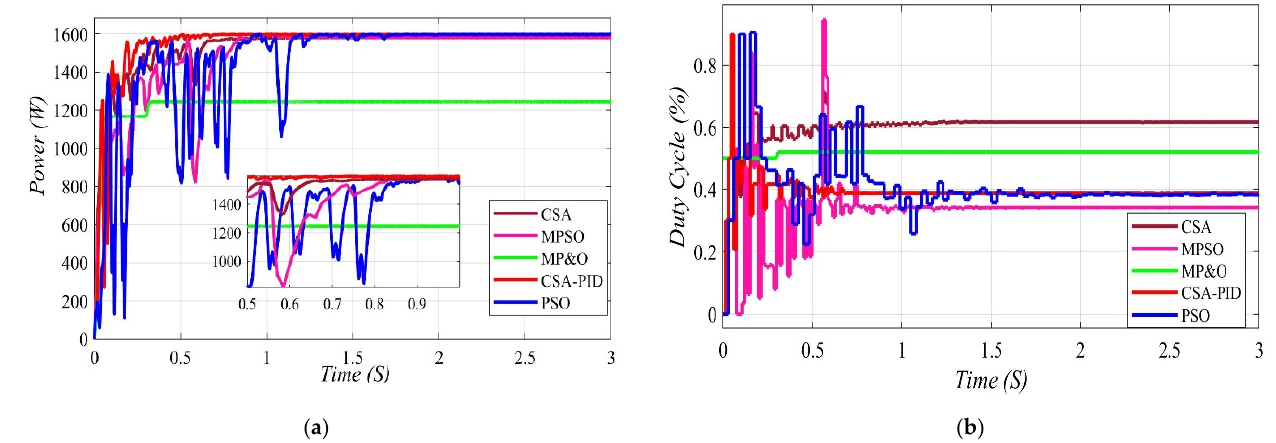
Figure 16. Details of duty cycle and power for proposed CSA-PID, CSA, MPSO, PSO, and MP&O controllers under scenario two. ( a ) The output power of proposed CSA-PID, CSA, MPSO, PSO, and MP&O. ( b ) The output duty cycle of proposed CSA-PID, CSA, MPSO, PSO, and